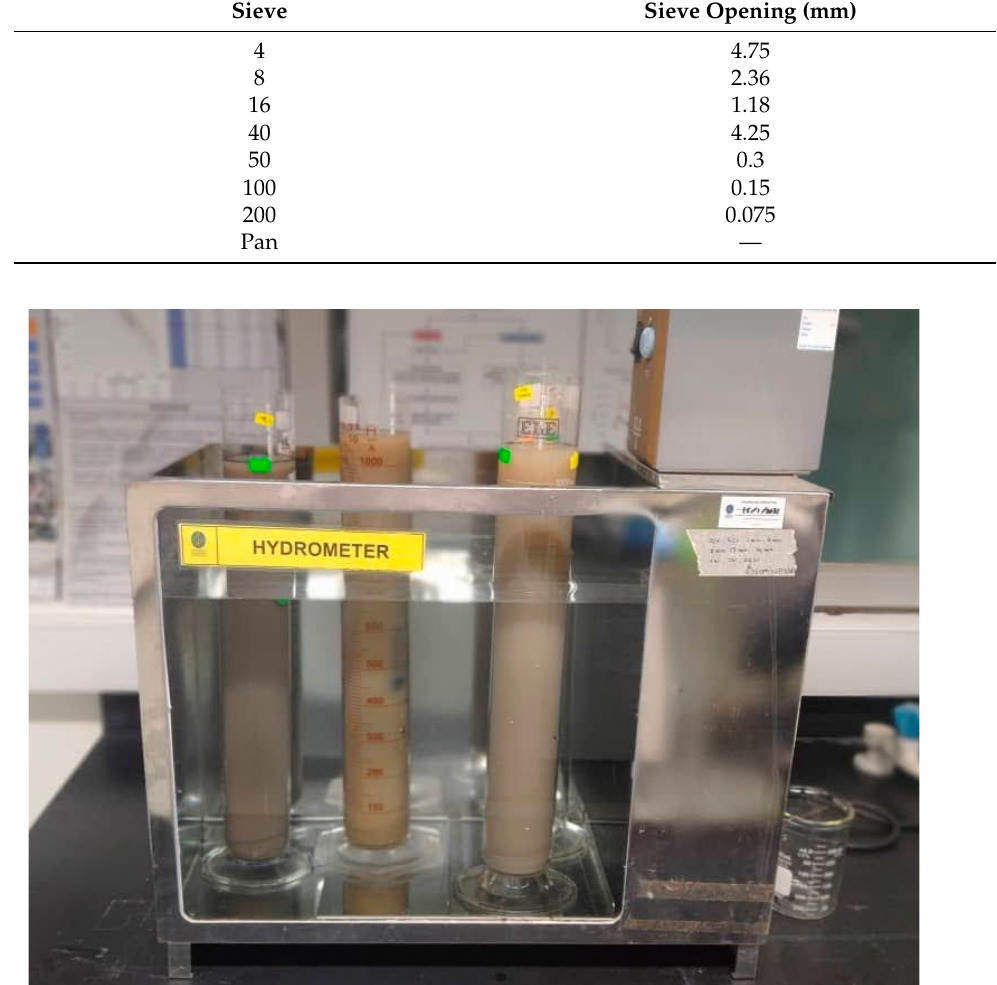
Figure 5. The hydrometer test setup for the finer fraction of the samples.